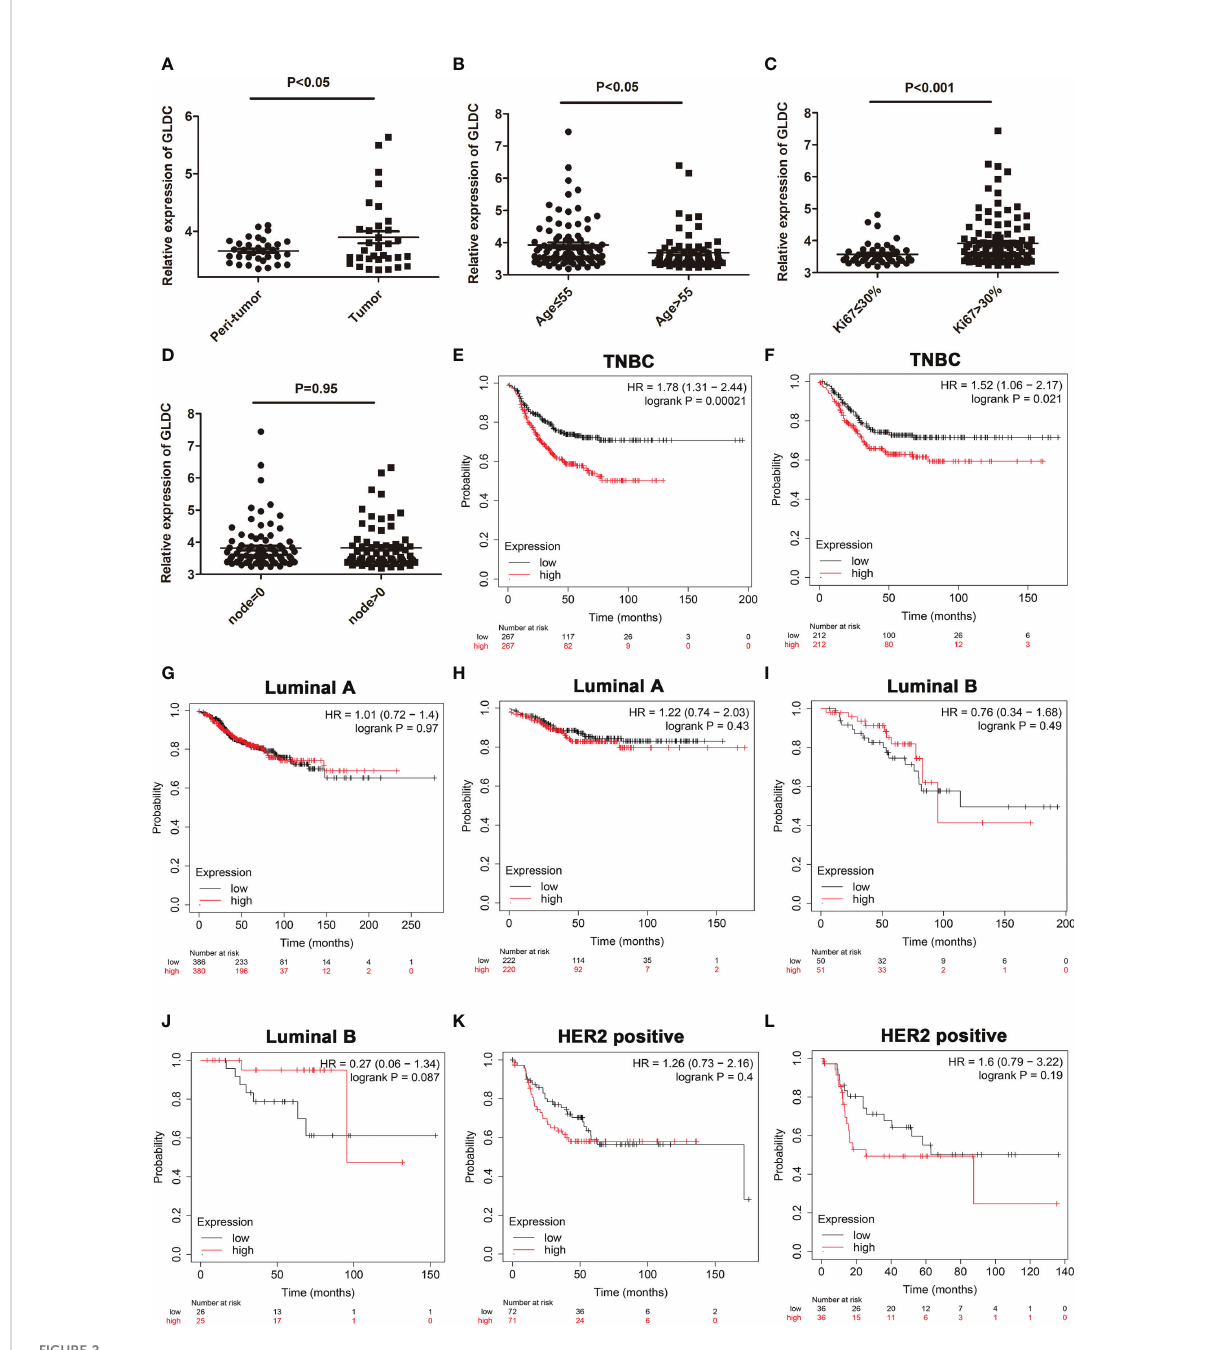
FIGURE 2 The expression pro fi les of GLDC and its prognoses value in TNBC tissues. (A) The expression of GLDC was signi fi cantly higher in the TNBC tissues compared with their adjacent normal tissues (n=33). (B) The expression of GLDC is higher in the patients younger than 55 years (age ≤ 55) than the patients older than 55 years (age>55). (C) GLDC expression in the patients with ki67 ≤ 30% was less than that with ki67>30%. (D) No signi fi cant differences were detected on the expression of GLDC between positive lymph nodes and no positive lymph nodes. (E, F) TNBC patients with high levels of GLDC were associated with the shorter RFS (E) and the worse DMFS (F) . (G, H) There were no signi fi cant differences on the RFS (G) and DMFS (H) between the low levels of GLDC and the high levels of GLDC in Luminal A breast cancer. (I, J) No signi fi cant differences were detected on the RFS (I) and DMFS (J) between the two groups in Luminal B breast cancer. (K, L) There were no signi fi cant differences on the RFS (K) and DMFS (L) between the two groups in HER2 positive breast